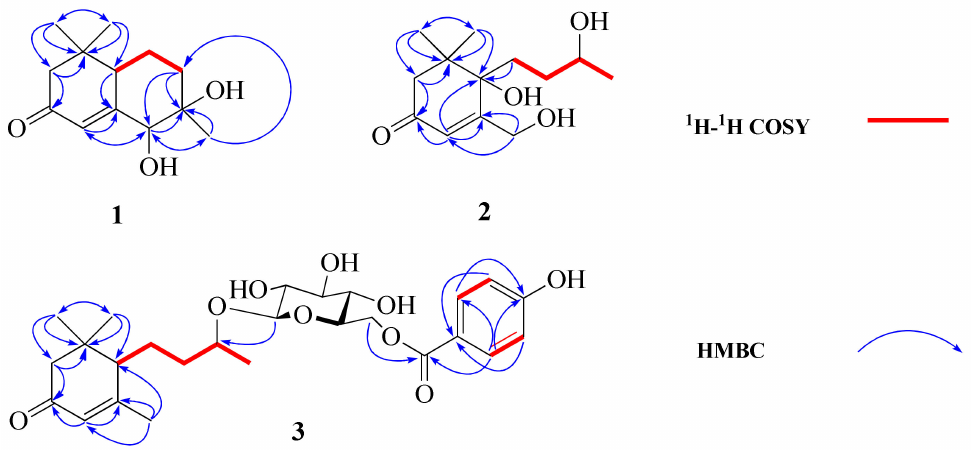
Figure 2. 1 H- 1 H COSY and key HMBC correlations of compounds 1 – 3